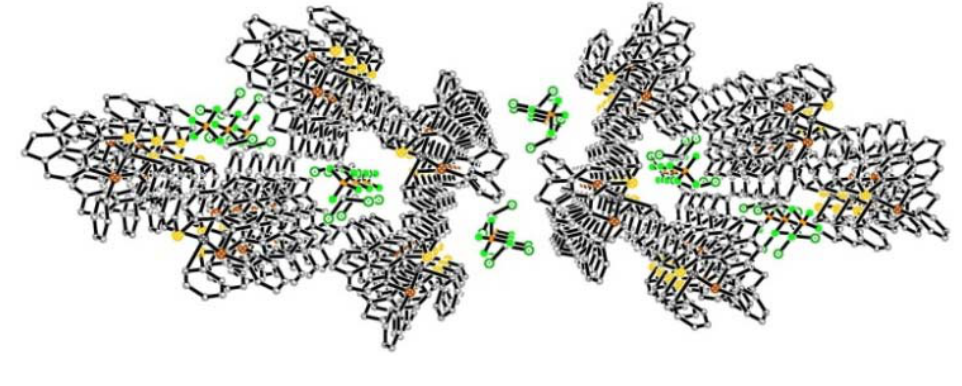
Figure 5. Complex 1 viewed down the z-axis; BF solvent molecules stack in channels between the acenaphthene fragments. The packing of complexes 2 and 3 , viewed down the y-axis is displayed in Figure S2, ESI.